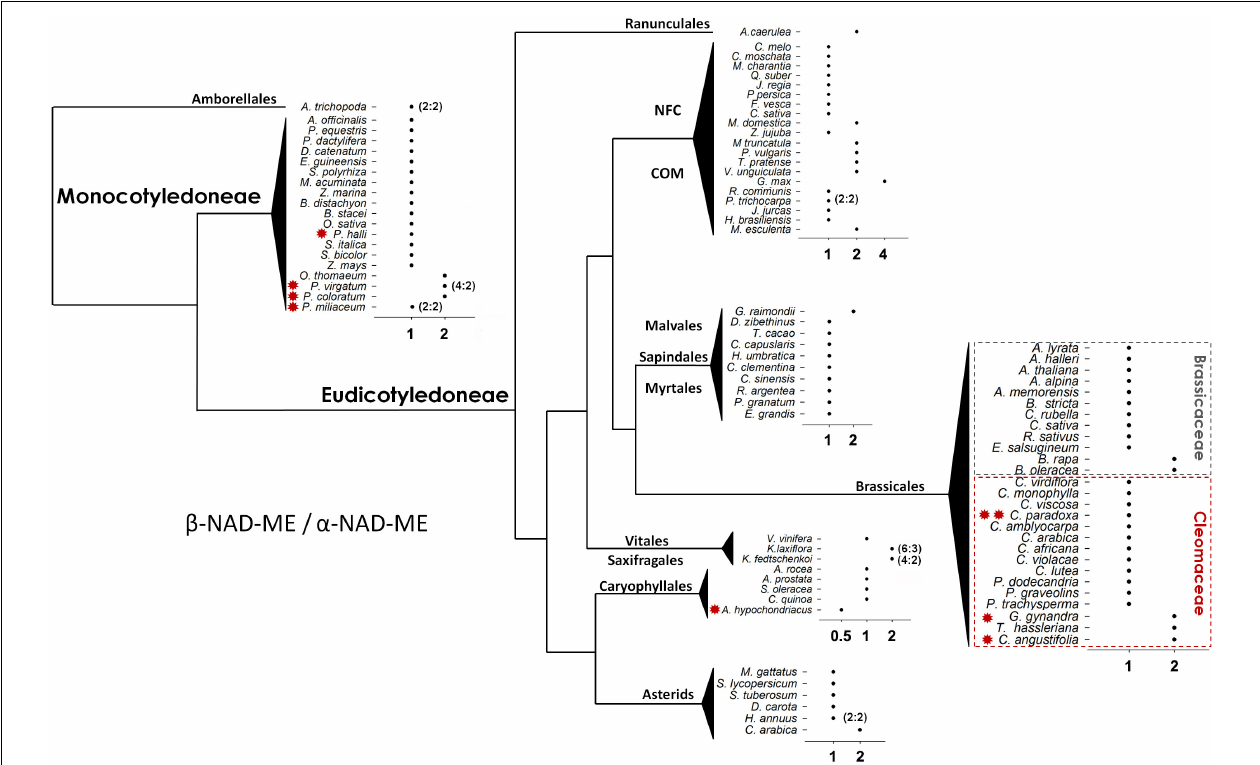
FIGURE 2 | Scheme showing the ratio of β -NAD-ME to α - NAD-ME gene composition in Angiosperms. Most species have the same copy number (1 to 1). In the cases where the relative proportion and absolute composition differ, the absolute β to α gene dosage is indicated in parentheses. Schematic representation of the values with the species grouped according to their order and family interrelationships (APG IV, 2016). COM: Celastrales, Malpighiales, and Oxalideles. NFC (Nitrogen Fixing Clades): Rosales, Fabales, Cucurbitales, and Fagales. Red * and ** indicate C 4 -NAD-ME and C 3 –C 4 photosynthetic metabolism, respectively. The scheme was created as a free art illustration where the lines do not represent branch